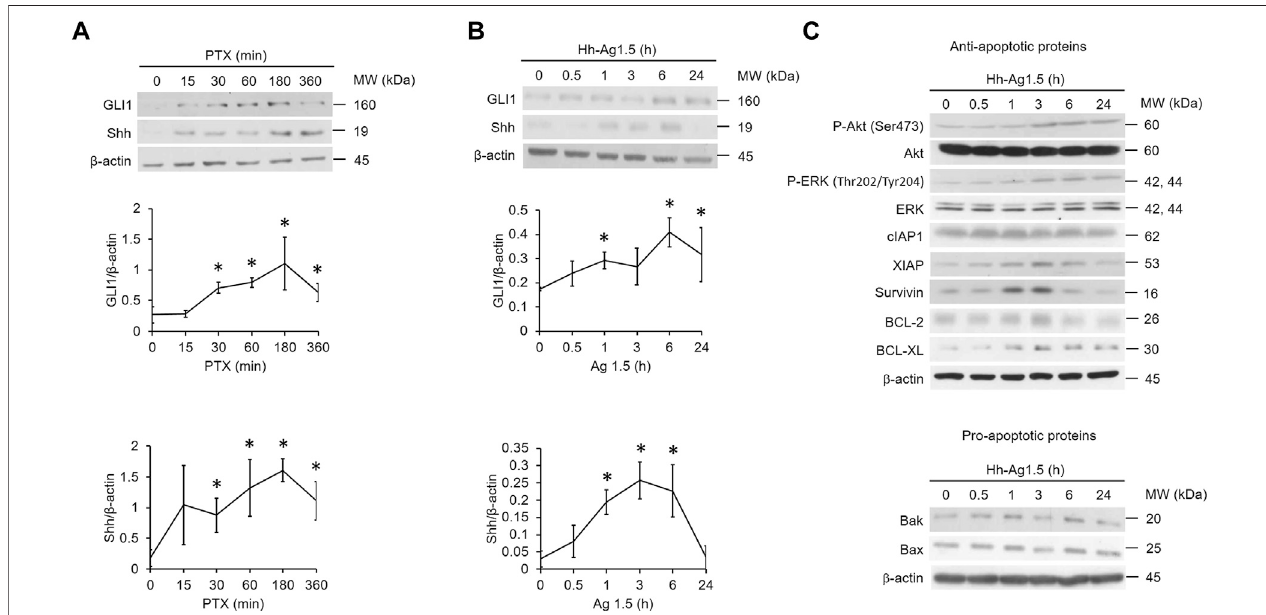
FIGURE 1 | Hedgehog signaling is induced by paclitaxel. (A,B,C) A549 cells were treated with paclitaxel (PTX; 20 nM) or Hh-Ag1.5 (1 nM) for the indicated times. Then, total cell lysates were immunoblotted using anti-GLI1, anti-Shh, anti-P-Akt, anti-Akt, anti-P-ERK, anti-ERK, anti-XIAP, anti-survivin, anti-cIAP1, anti-BCL-2, anti- BCL-XL, anti-Bax, anti-Bak, and anti- β -actin antibodies. Protein band intensities were analyzed using ImageJ. *: p < .05; indicates statistically signi fi cant difference between 0 h or 0 min and the indicated time point. All experiments were performed at least three times. n = 3 for all groups.